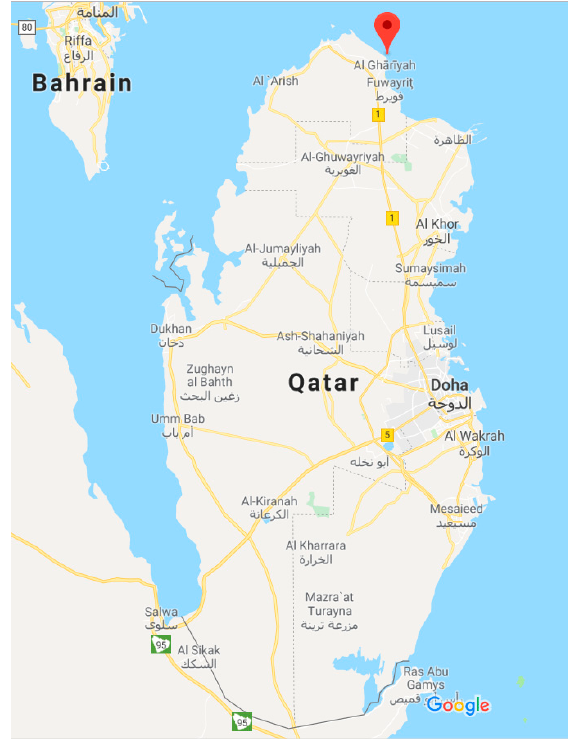
Figure 2. Map showing the location of the seawater sampling near the Arabian Gulf.